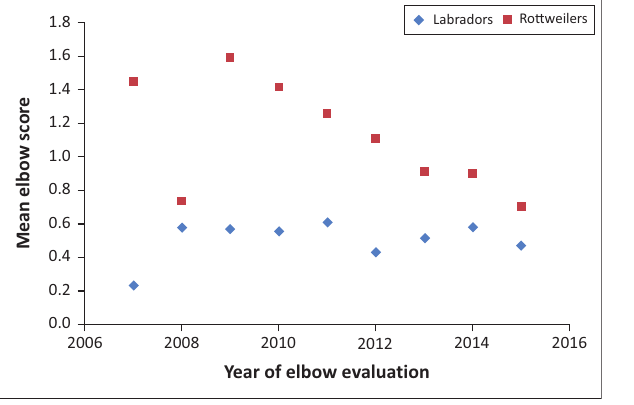
FIGURE 3: Mean total numerical score (0–6) of elbow dysplasia in Rottweilers and Labrador retrievers per year from 2007 to 2015. TABLE 3: Grade incidence of dogs with hip dysplasia (Grades C–E) in South Africa with data compared to that of the Orthopaedic Foundation of America from 2007 to 2015.